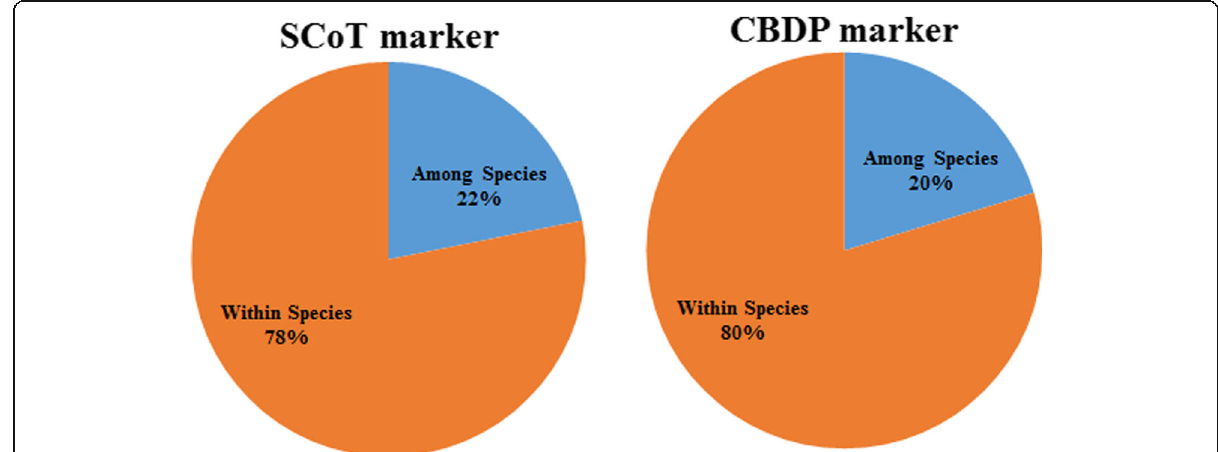
Fig. 1 Results of analysis of molecular variance using SCoT and CBDP markers in the 91 investigated wheat ’ s landraces and wild relatives